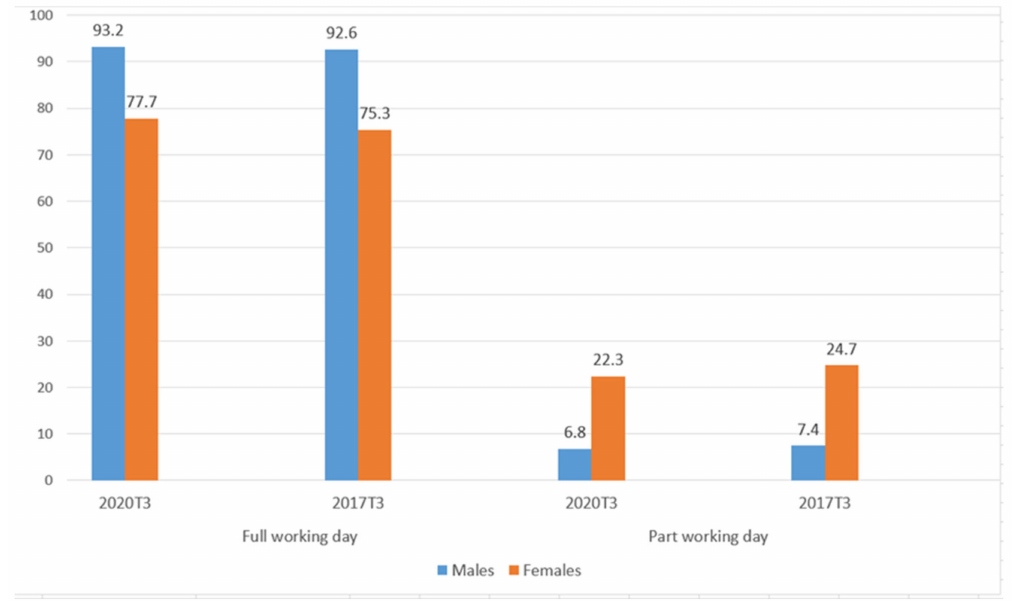
Figure 3. Working day by sex, in percentage (third quarter of 2017–2020). Source: Own elaboration from data of the Spanish National Statistics Institute (INE, (data free use)) [36].